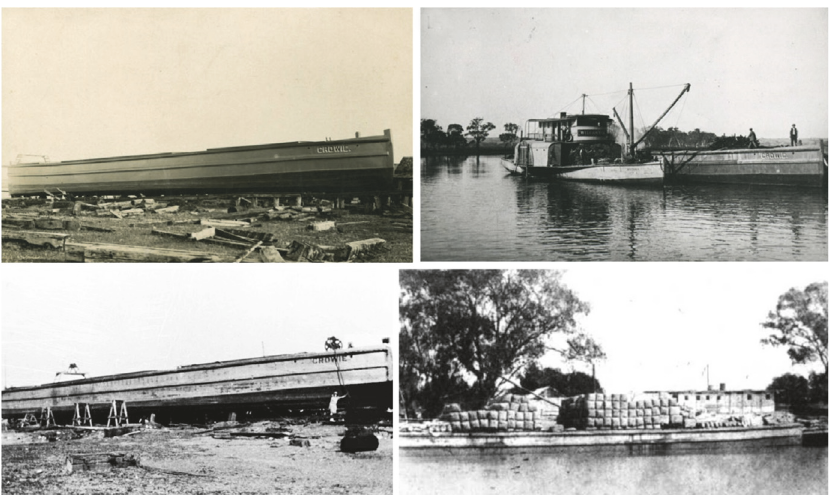
Figure 1: Photos of the Crowie barge (courtesy photograph of the State Library of South Australia, previously published in [13]: